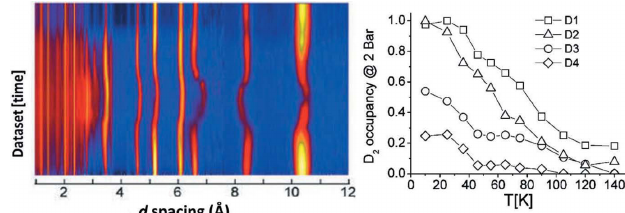
Figure 1 Neutron powder diffraction data for Cr(OH)(1,4-benzenedicarboxylate) loaded with D 2 , collected following initial loading at 25 K (measuring at 10 K) and during subsequent heating to 150 K under a constant pressure of 2.0 bar D 2 . The plot shows the site occupancies obtained from Rietveld refinement for D 2 at four locations in the framework. Reprinted and adapted with permission from Mulder et al. (2010). Copyright (2010) American Chemical